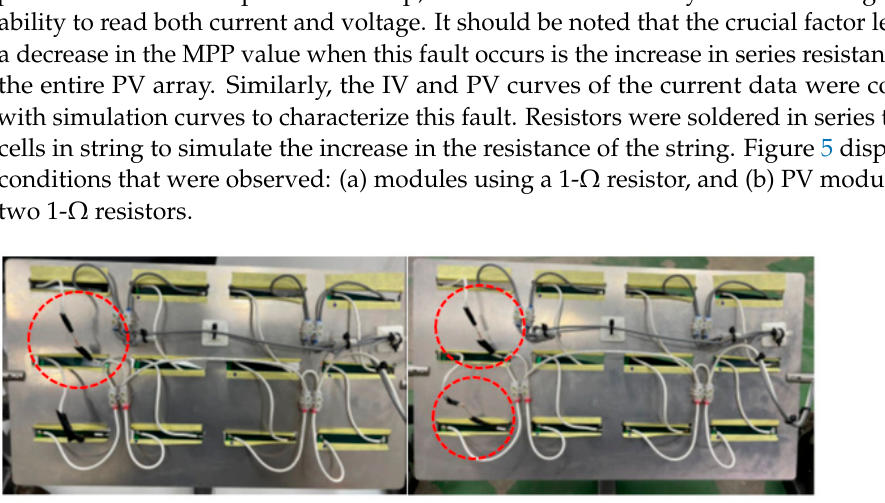
Figure 6. Solar radiation curve versus time of a PV reference cell.